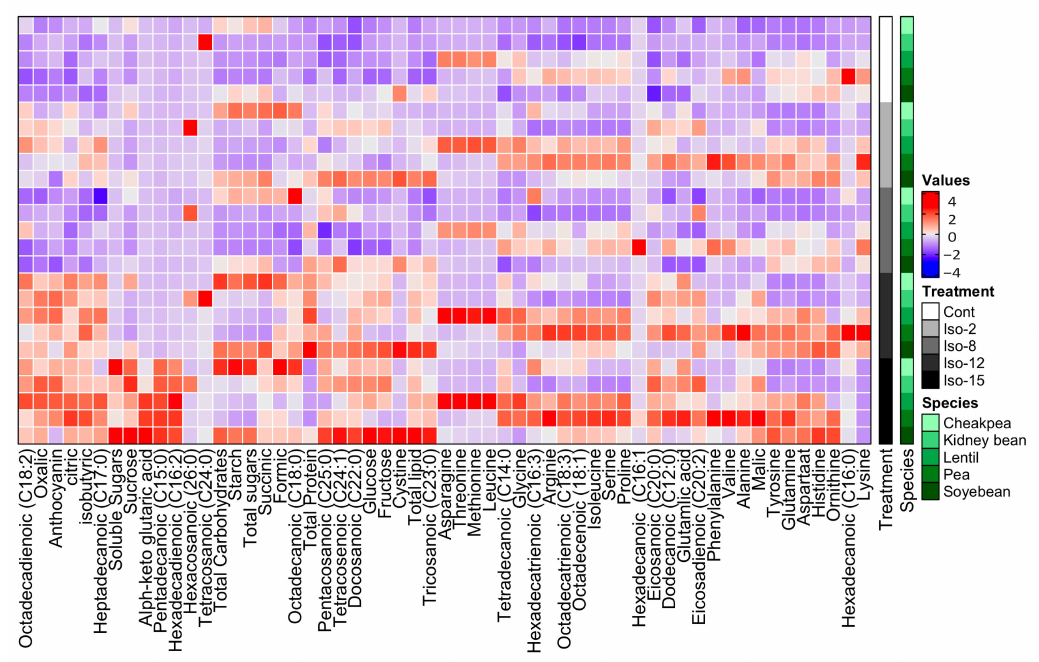
Figure 4. Heatmap showing the changes in the profile of amino acids, carbohydrates, organic acids, and lipids in seeds of soybean, kidney bean, chickpea, lentil, and pea under the e ff ect of soil enrichment with biologically active actinomycete